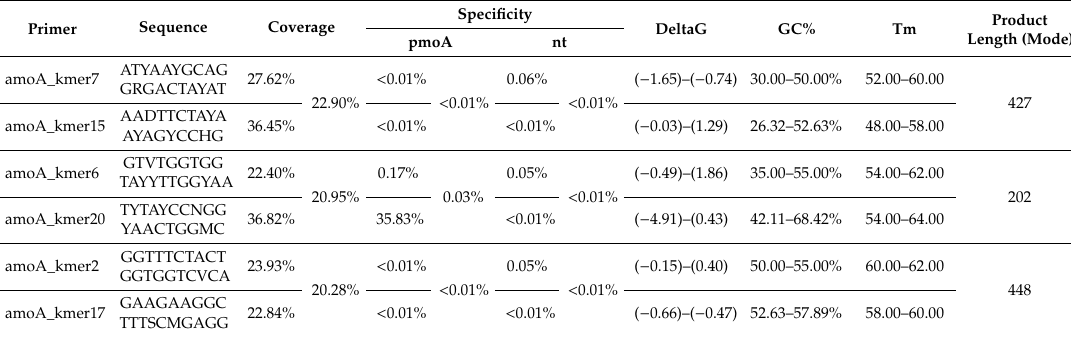
Table 4. Recommended primers with basic properties for amoA